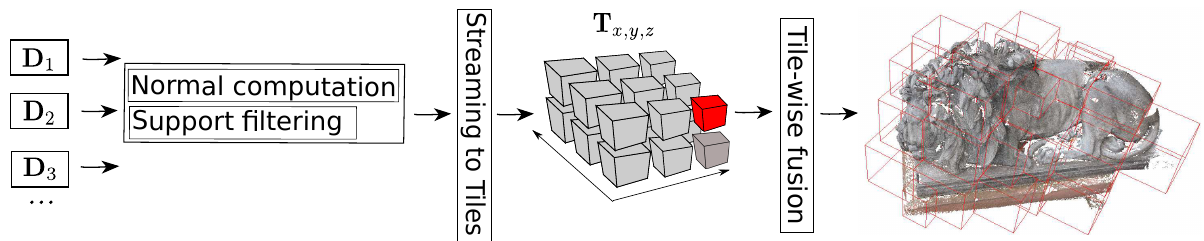
Figure 1: Flow chart of the proposed fusion algorithm. Depth images D i are sequentially filtered and point-wise normals are computed. On completion of each image, points and corresponding normals and image ids are streamed to 3D cubes regularly partitioning object space. The single cubes are then subject to the fusion